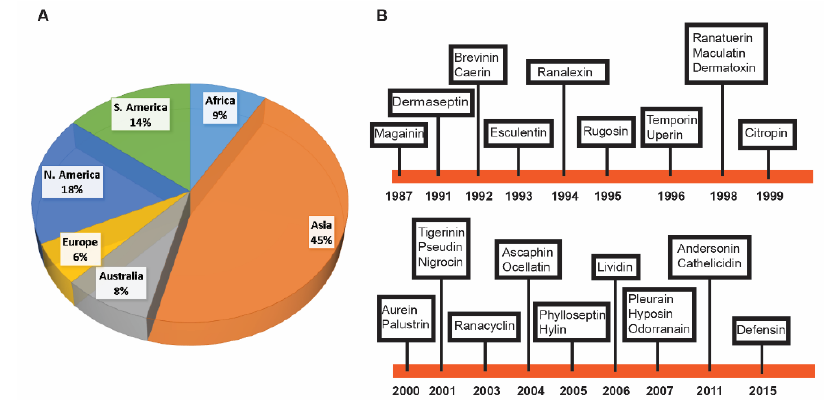
Figure 2. ( A ) Percentages of amphibian antimicrobial peptides discovered on different continents based on the APD (http://aps.unmc.edu/AP) as of June 2020; ( B ) Discovery timeline for major amphibian antimicrobial peptide families.